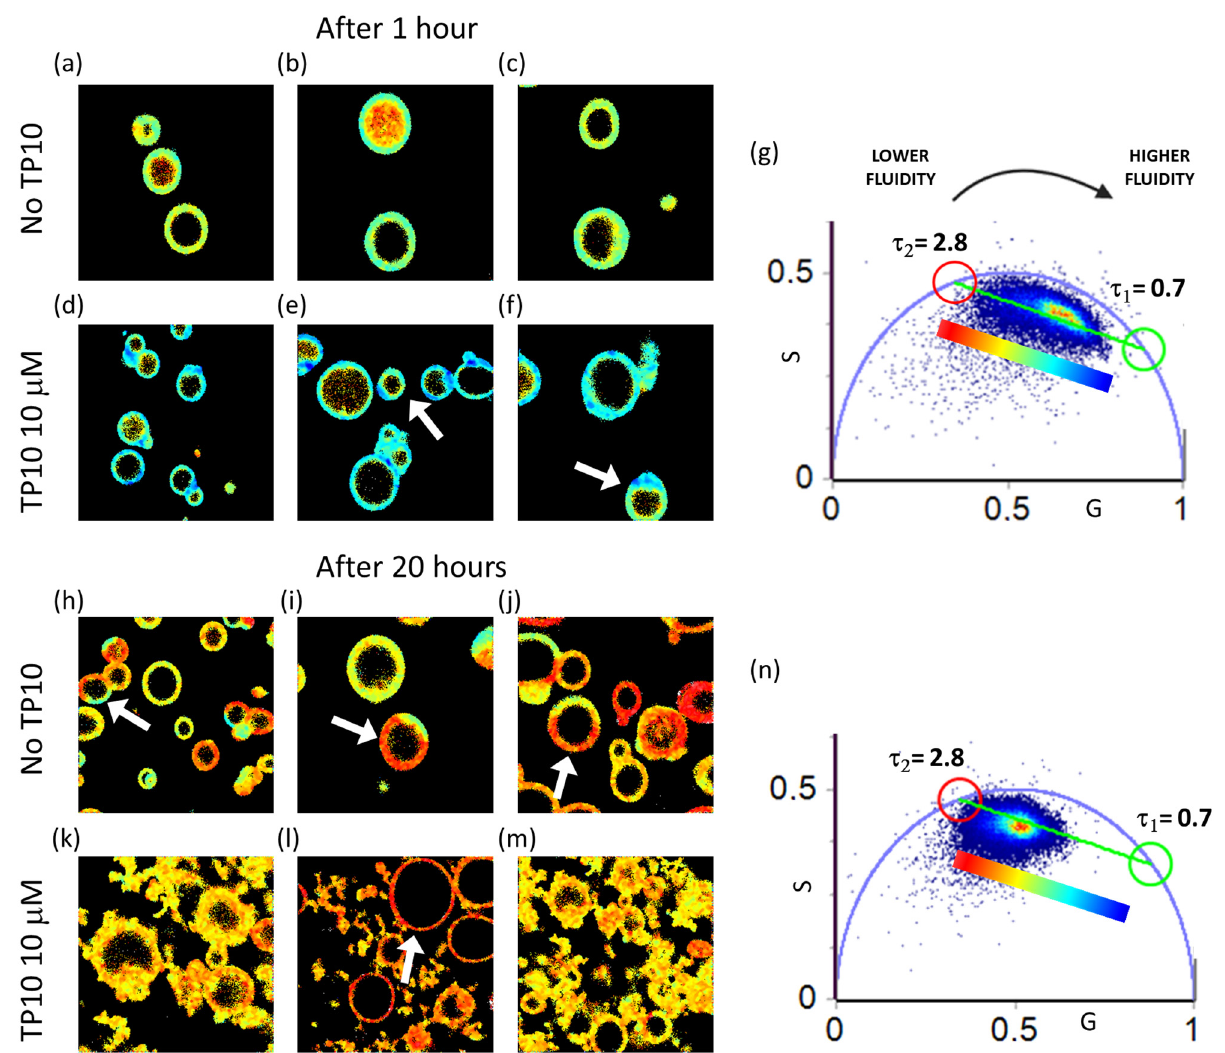
Figure 5. Phasor analysis of 256 × 256 pixels representative FLIM measurements from di-4- ANEPPDHQ ( λ exc = 470 nm, range 500–650)-stained GPMVs 1 h and 20 h after the addition of 10 μ M TP10. ( a – c ) Lifetime maps of control measurements from di-4-ANEPPDHQ-stained GPMVs in the absence of TP10. ( d – f ) Lifetime maps of control measurements from di-4-ANEPPDHQ-stained GPMVs 1 h after the addition of 10 μ M TP10. ( g ) Phasor plot from the analysis of all reported meas- urements performed after 1 h from the peptide addition. ( h – j ) Lifetime maps of control measure- ments at the 20-hour time point from di-4-ANEPPDHQ-stained GPMVs in the absence of TP10. ( k –